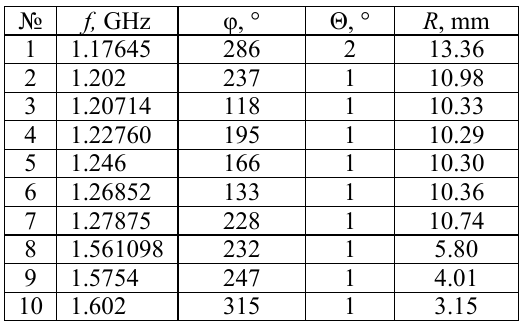
Table 1. The PCO